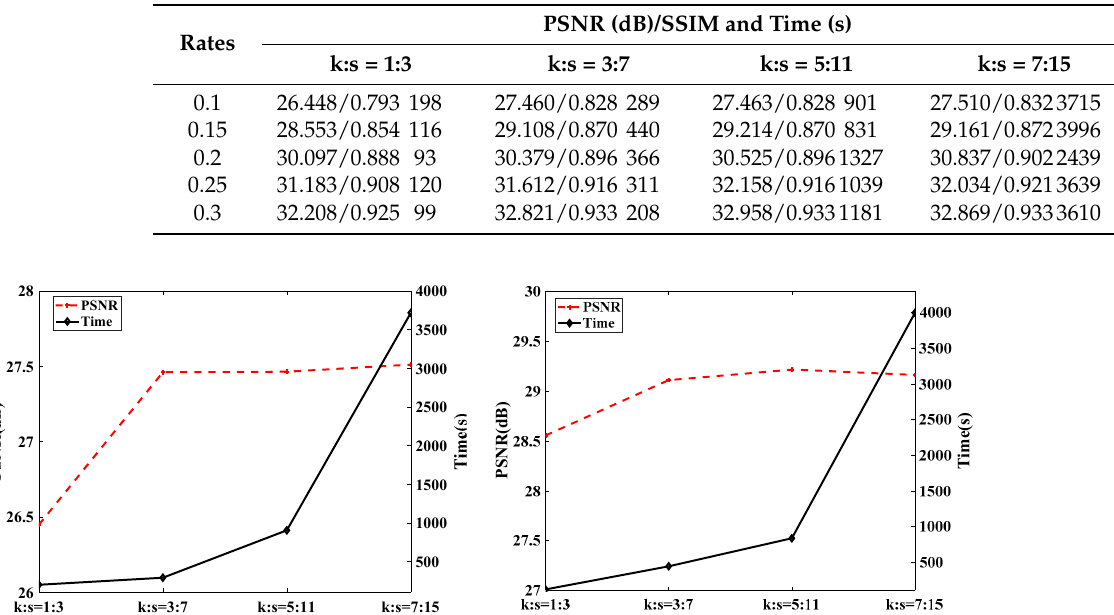
Figure 2. The PSNR and time curves for different k:s ratios: ( a ) measurement rates = 0.1 and ( b ) measurement rates = 0.15.